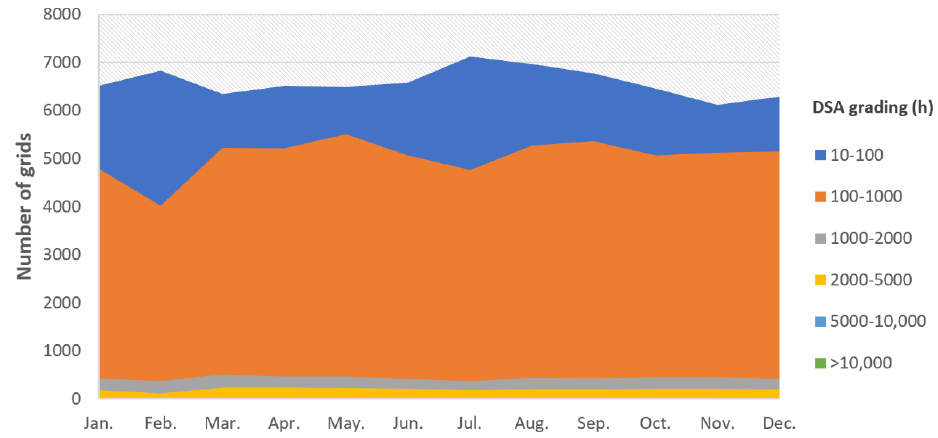
Figure 5. DSA monthly change in the lower reaches of the Yangtze River.